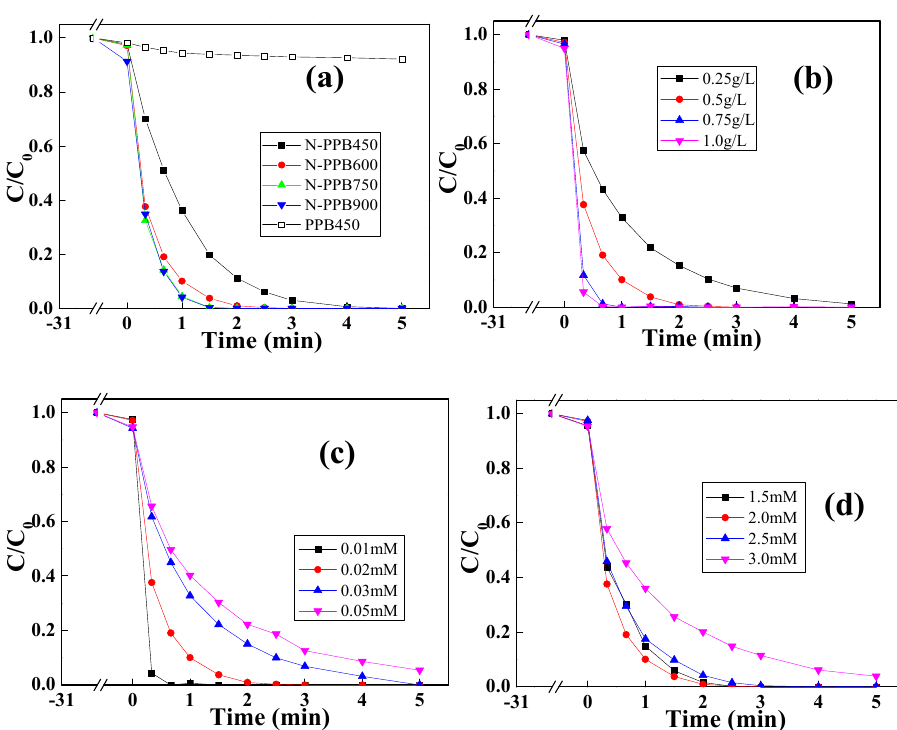
Figure 4. ( a ) Catalytic performance of N − PPB samples ([catalyst] 0 = 0.5 g/L, [BPA] 0 = 0.02 mM, [PMS] 0 = 1.5 mM), impact of ( b ) catalyst dosage ([BPA]0 = 0.02 mM, [PMS] 0 = 1.5 mM), ( c ) BPA concentration ([catalyst] 0 = 0.5 g/L, [PMS] 0 = 1.5 mM), and ( d ) PMS concentration on the performance of N − PPB600 ([catalyst] 0 = 0.5 g/L, [BPA] 0 = 0.02 mM). N-PPB600 was selected for the following test. The impact of reaction parameters, including BPA concentration, catalyst dosage, and PMS concentration on the performance